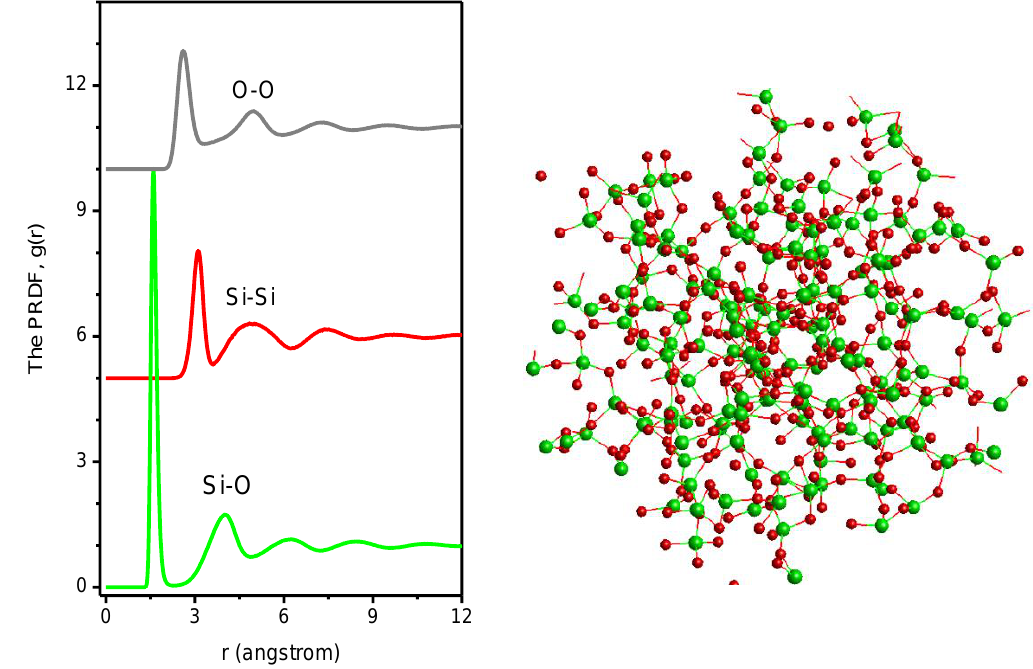
Figure 2. The PRDF (left) and snapshots of arrangement of atoms (right) in the SiO 2 liquid at 2600 K and ambient pressure; blue (large) and red (small) spheres represent Si and O,